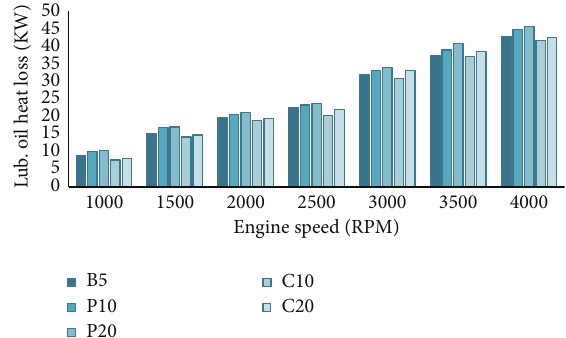
) for all tested blends at full oil